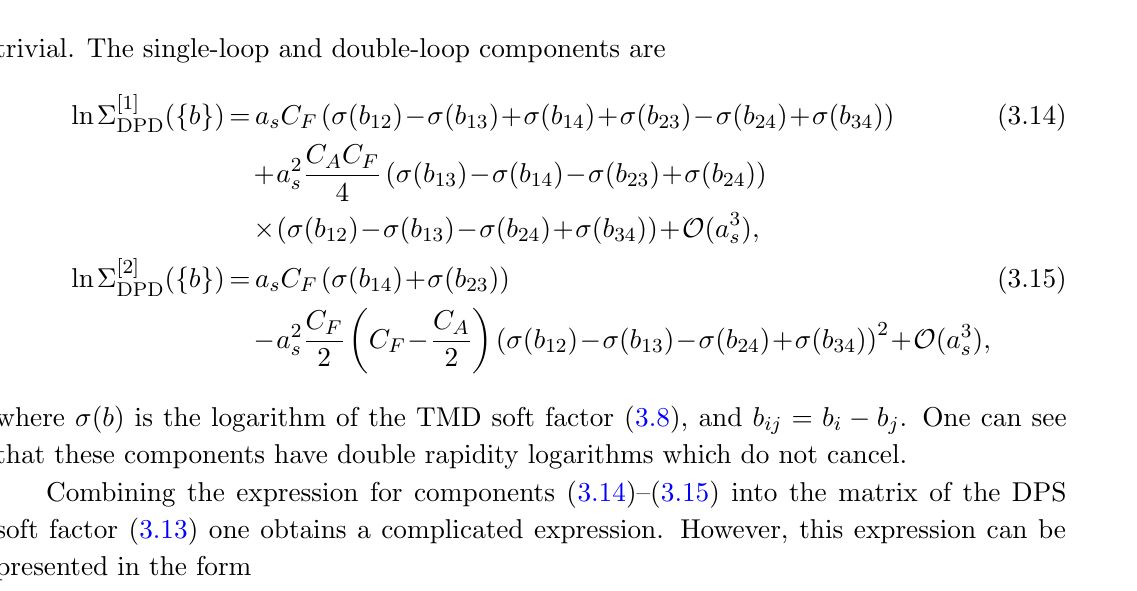
Figure 2 . Visualization of (cid:6) [1] (left), which has a topology of the single Wilson loop, and DPD (cid:6) [2] (right), which has topology of the double Wilson DPD